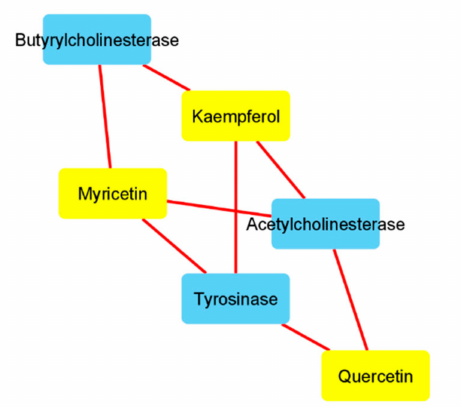
Figure 3. Components-targets analysis conducted on quercetin, kaempferol, and myricetin. The inter- actions between these phytochemicals and the enzymes tyrosinase and acethylcholinesterase were pre- dicted by the bioinformatics platform SwissTargetPrediction (http://www.swisstargetprediction.ch/). Quercetin, kaempferol, and myricetin were selected according to their prominent position on the components-targets analysis (Figure 1), whereas the enzymes were selected based on the intrinsic enzyme inhibitory effects showed by the A.cordifolia extracts (Table